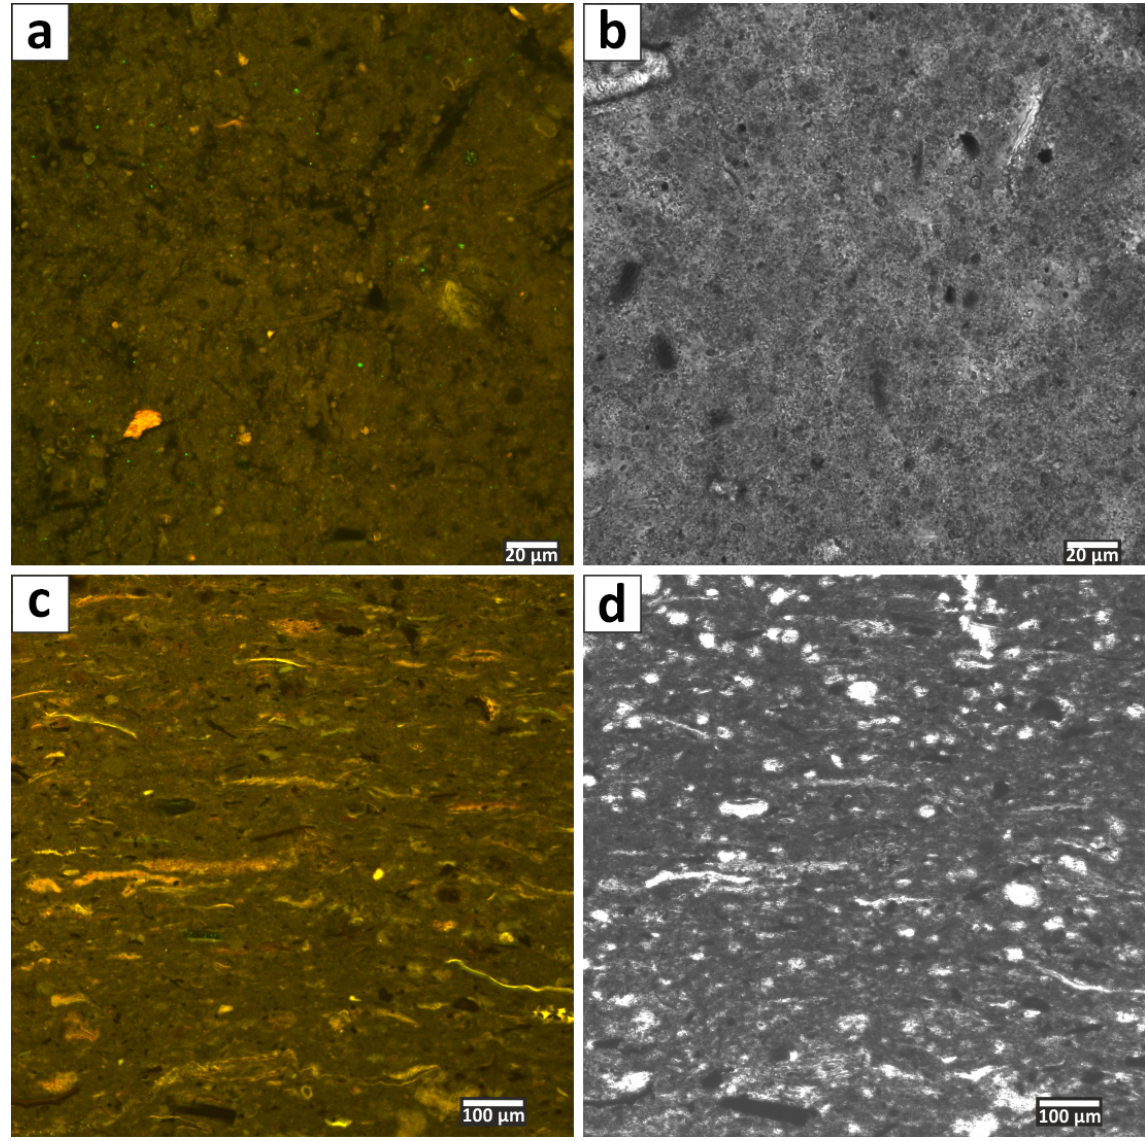
Figure 4. (a) Laser scanning micrograph (excitation 365nm; emission 397–700nm) of Unit I microfabric at 2cm depth. The small and randomly orientated plant particles show bright fluorescence due to their chlorophyll content. (b) Same section in transmitted light. (c) Flu- orescent texture of Unit III (at 28cm depth) is visible. The higher amount of plant detritus, particle layering and a compacted matrix are notable. Voids are resin-embedding artifacts. (d) Same section as in (c) but under transmitted